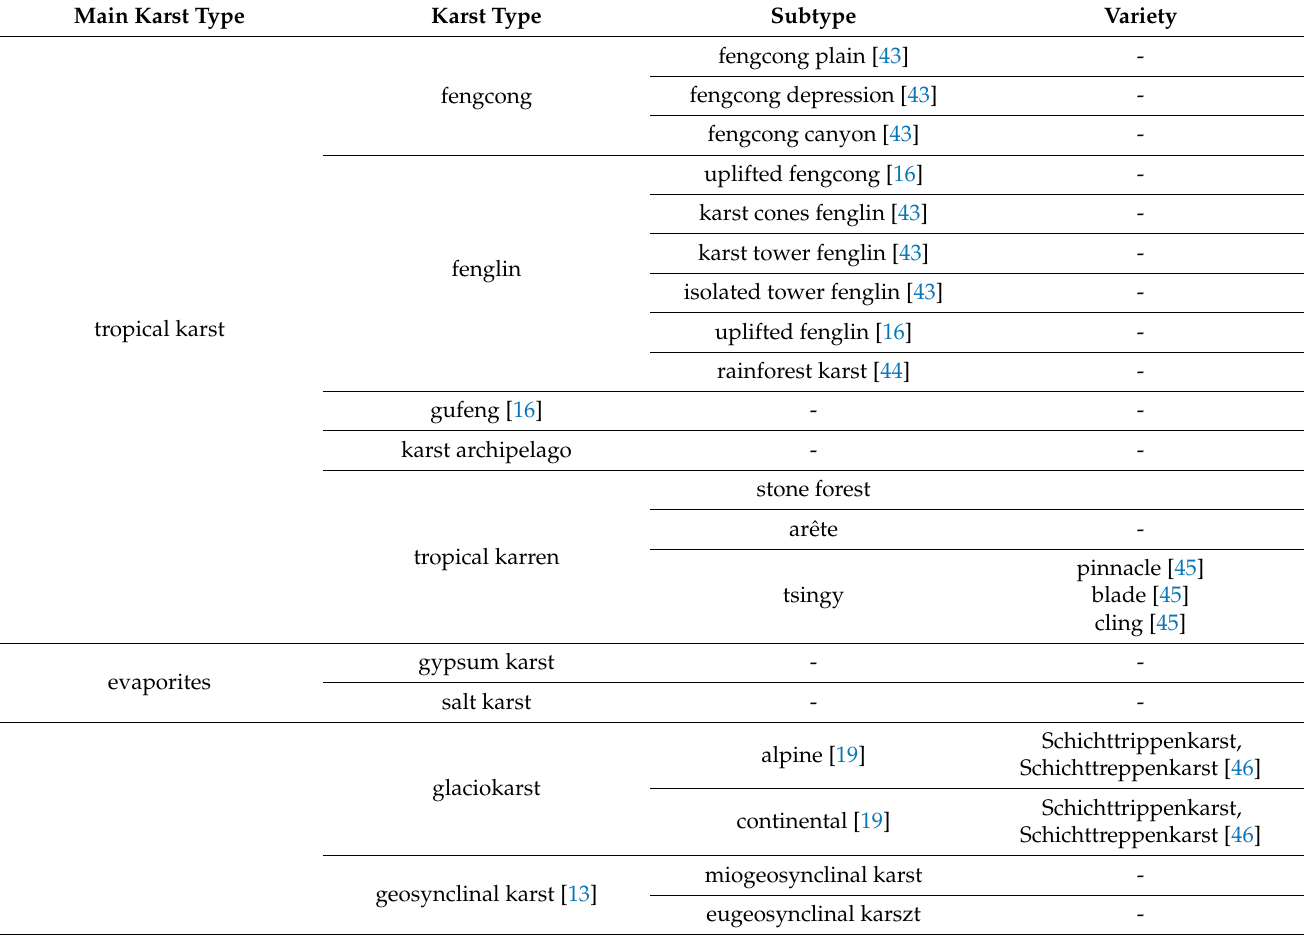
Table 3. Some examples for the classification of karst types.